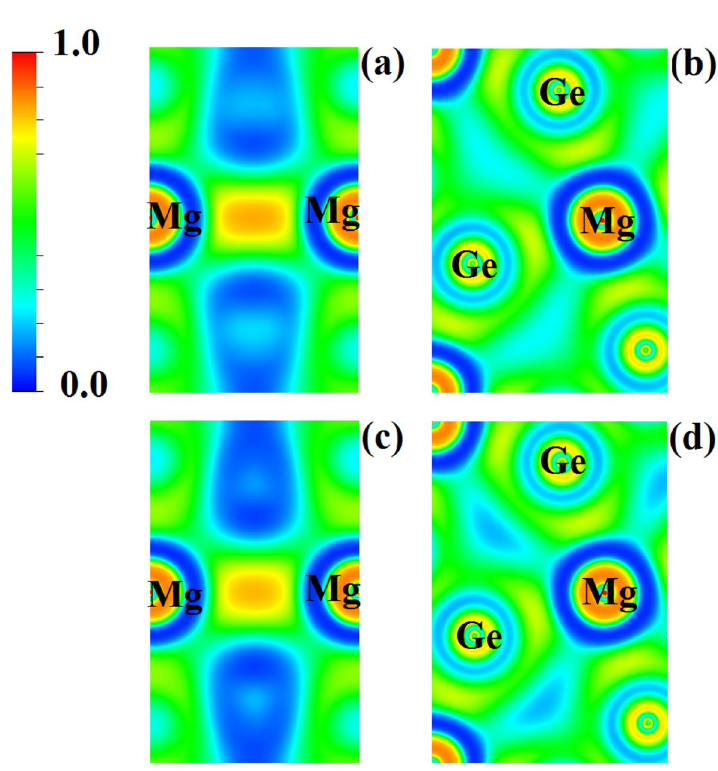
Figure 7. Electron localization function in the ( a , c ) (200) and ( b , d ) (001) planes for ( a , b ) Nd 2 MgGe 2 and ( c , d ) Gd 2 MgGe 2 .